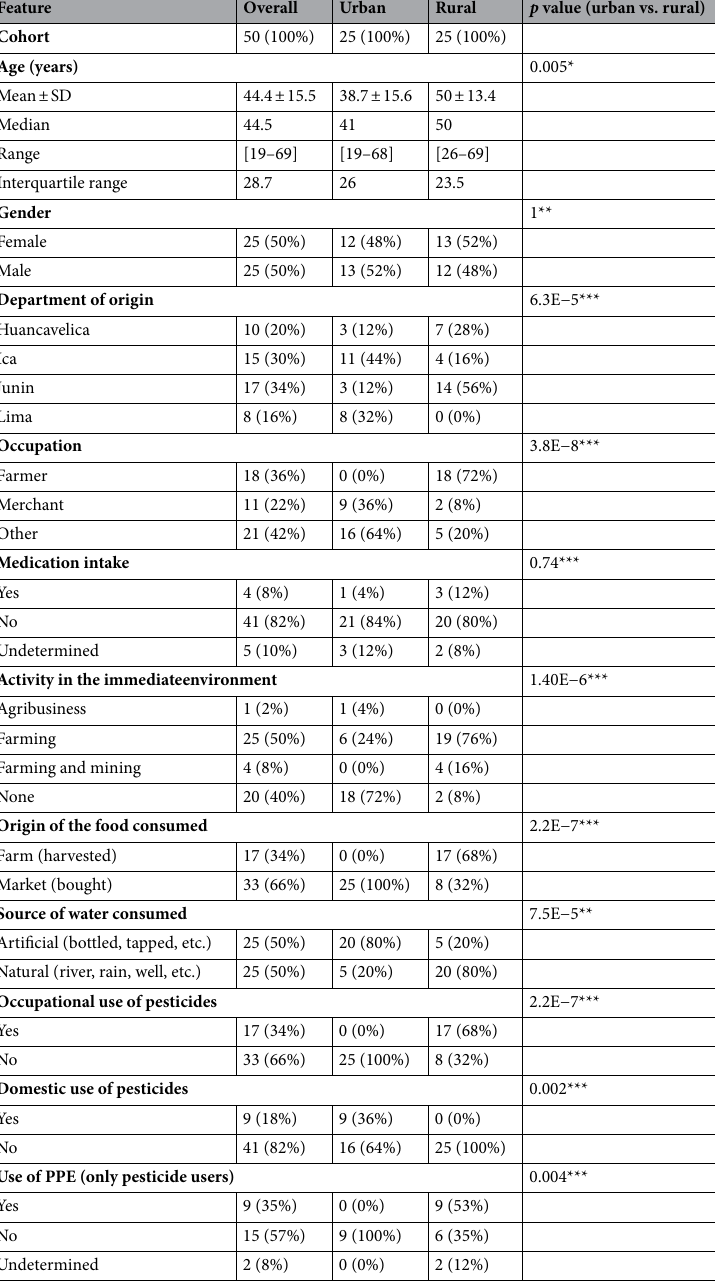
Table 1. Baseline socio-demographic characteristics of the 50 adult Peruvian participants in the study. Mean values are presented ± standard deviation (SD). Percentages are expressed as ratios of the individuals considered in the parameter with: Pesticide users, N = 26; Rural pesticide users, N = 17; Urban Pesticide users, N = 9. * t -test; ** χ 2 test; ***Fisher’s exact